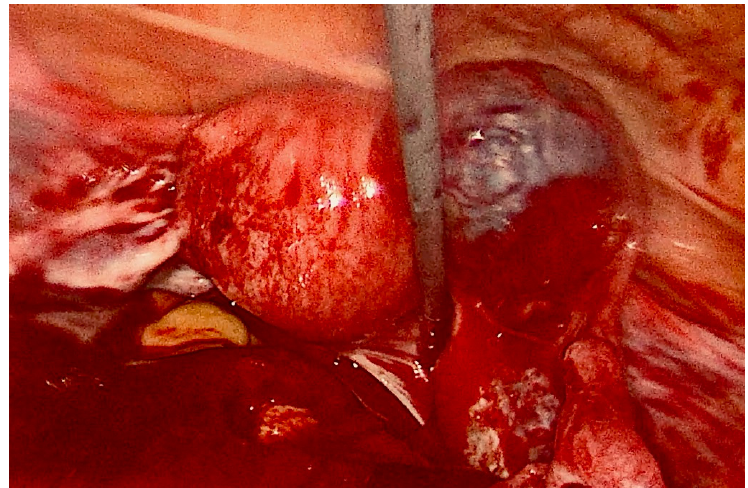
Figure 3. Laparoscopic view of interstitial pregnancy.